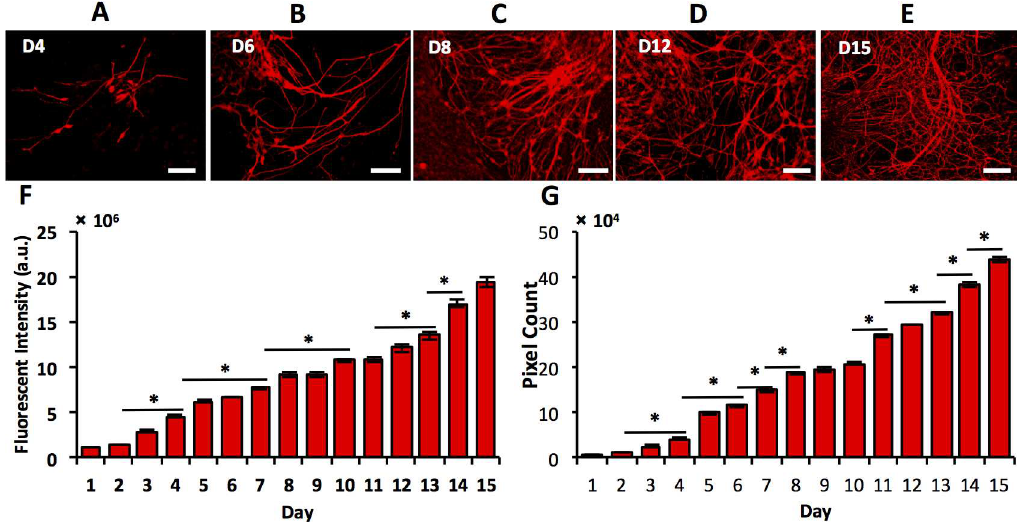
Fig 4. Immunocytochemical analysesof TuJ stained images. (A-E) Differentiating mESCs immunostained for TuJ (beta-III tubulin)on different days of co-culture with PA6 cells. (F) TuJ expressionquantifiedusing daily fluorescent intensity measurements show continuousincrease in protein content in culture. (G) An independentadaptive thresholdingmethod appliedto TuJ-stainedimages shows increasingTuJ expressionover the culture period. Scale bar: 100 μ m. * indicates p <